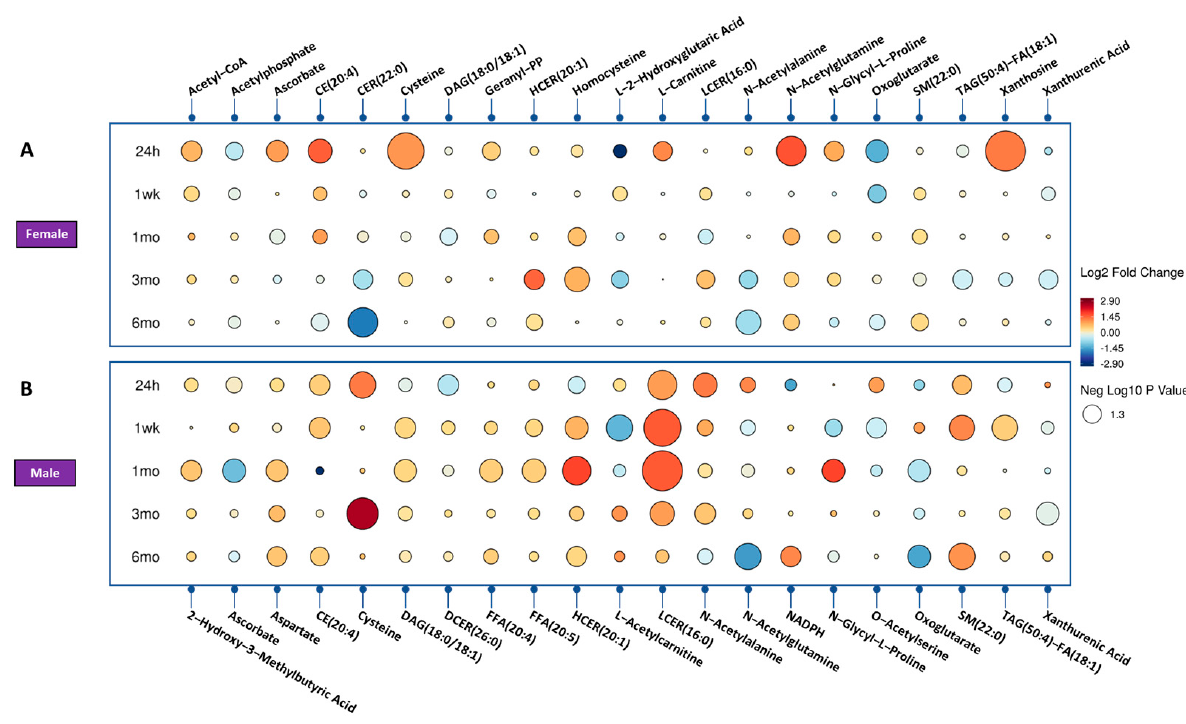
Figure 3. Radiation effect of mice for significantly dysregulated biomarkers across time. (Panel A ) showing the female mice radiation response and (Panel B ) shows the male mice radiation effect. Each circle in the figure denotes a fold change, where red indicates an increase and blue indicates a decrease. The size of each circle corresponds to the level of statistical significance, with larger circles indicating greater statistical significance.